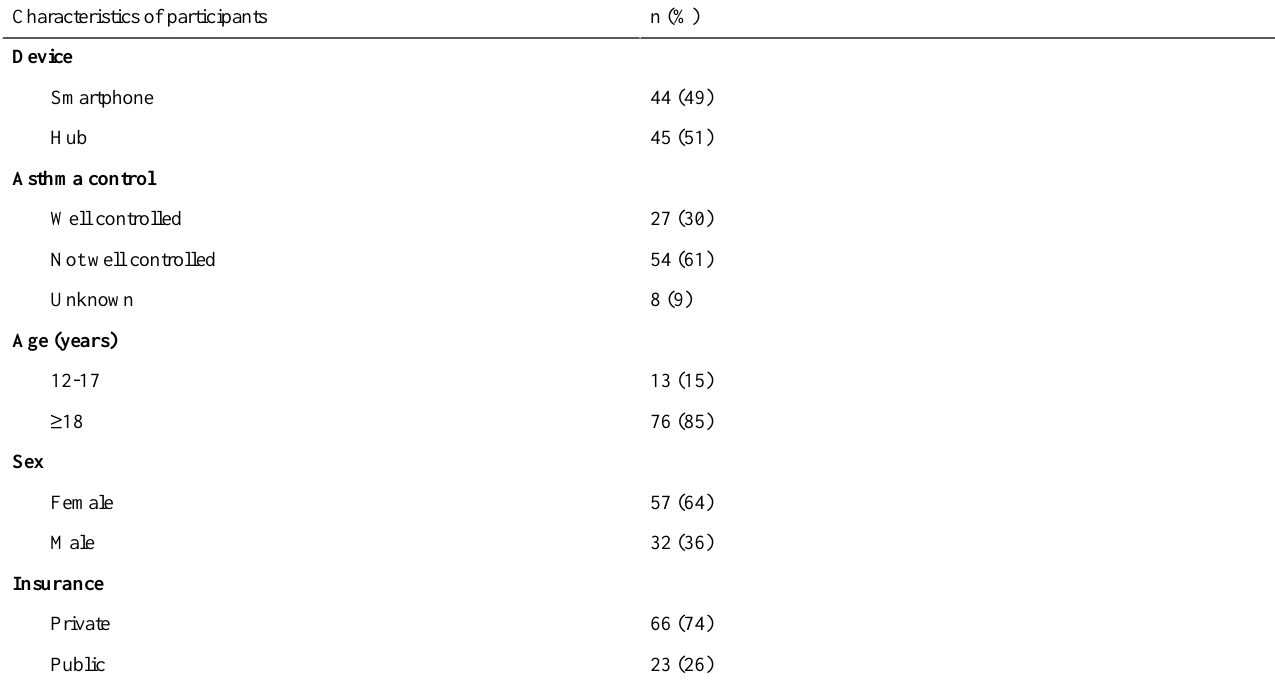
Table 1. Characteristics of participants who responded to the exit survey